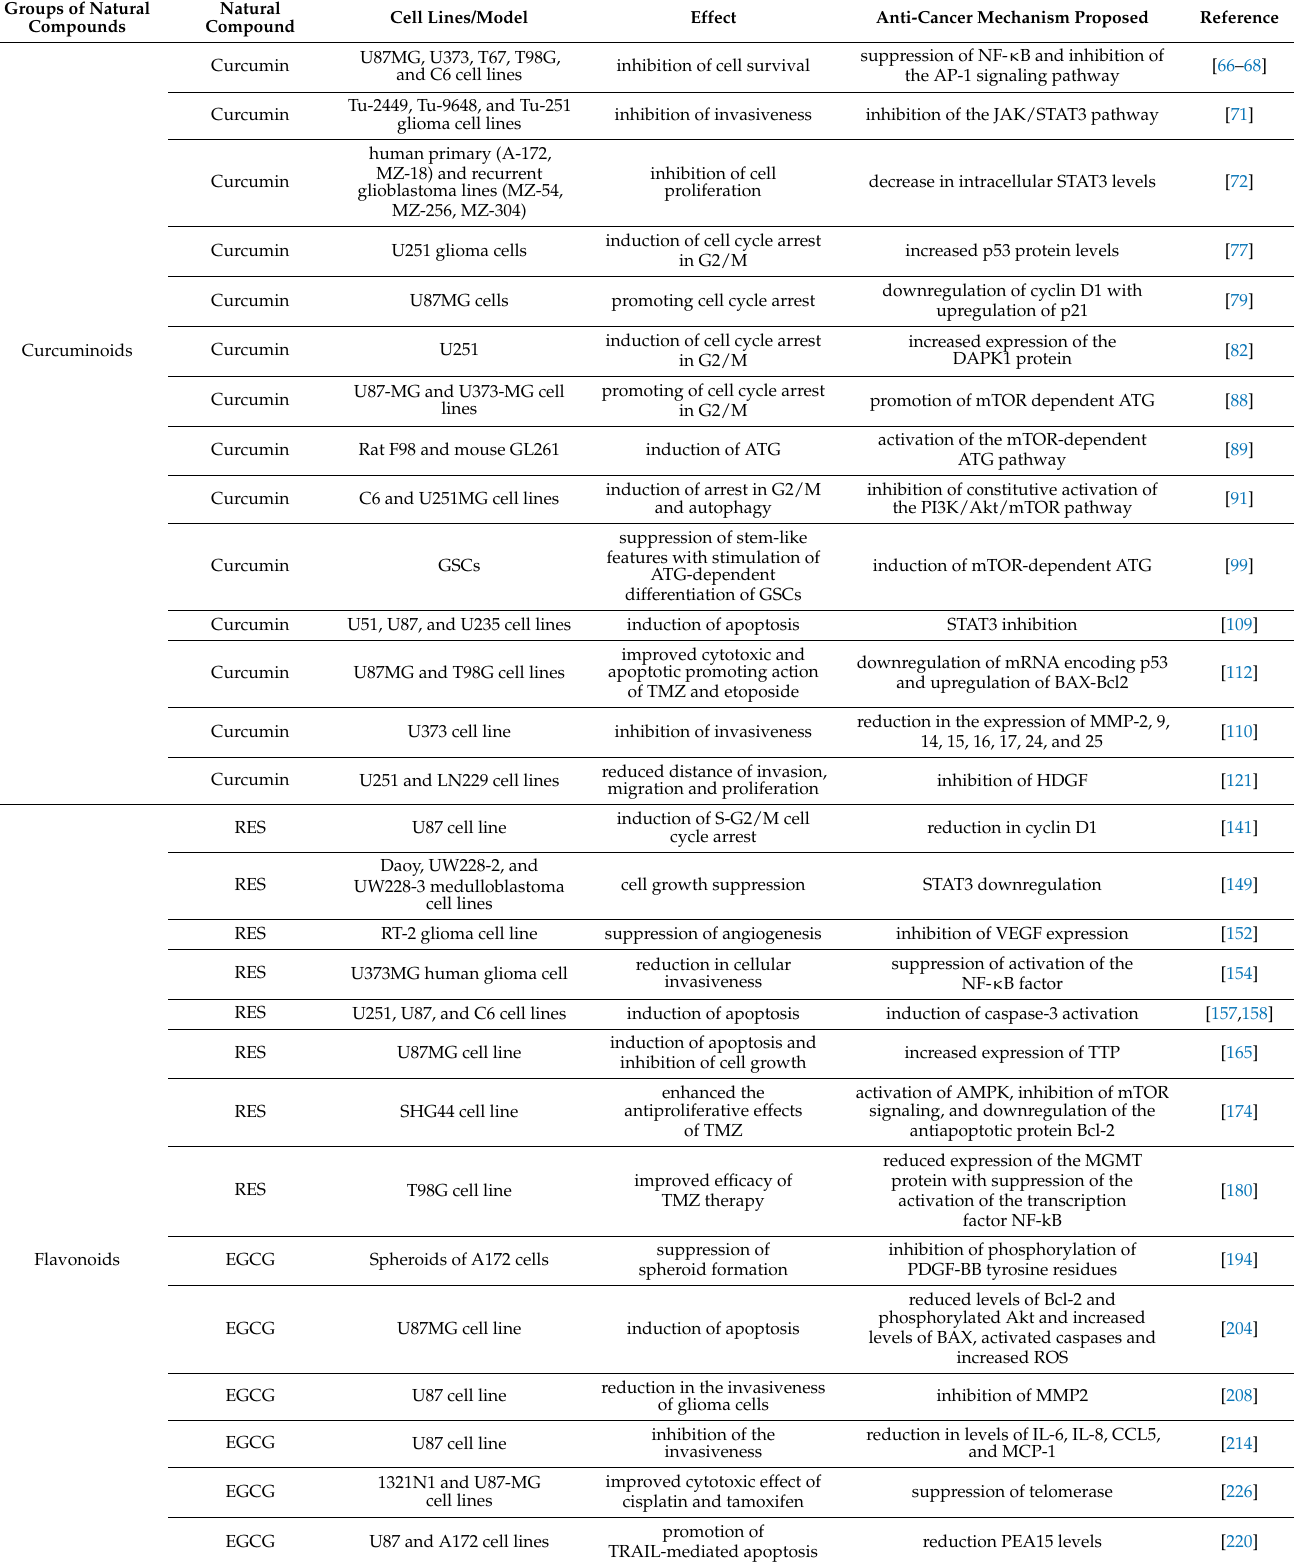
Table 1. Main anti-glioma effects observed in preclinical studies for curcumin, RES, and